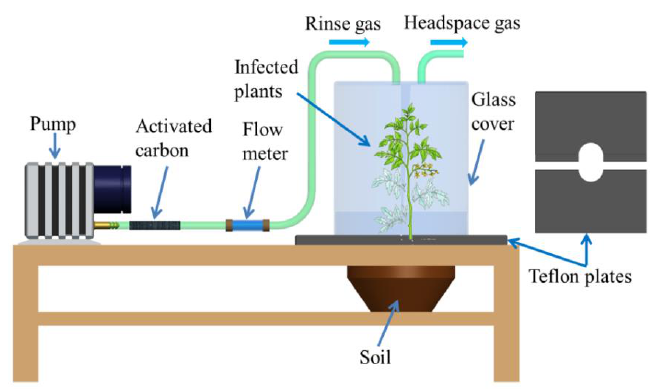
Figure 2 Illustration of VOC collection system for infected plants. Figure 2. Illustration of VOC collection system for infected